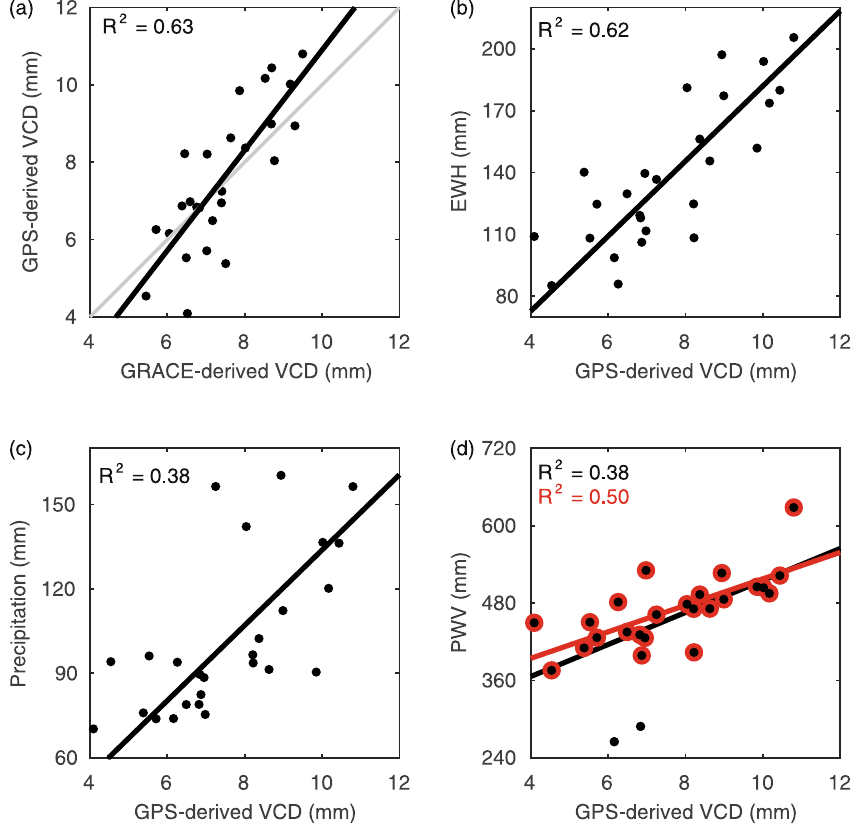
Figure 4. Empirical relations of the annual amplitude between GPS-derived VCD and other quantities. ( a ) for GRACE-derived VCD, ( b ) for EWH, ( c ) for precipitation, and ( d ) for PWV. The red line in ( d ) is the linear fitting line without two abnormal stations, Lijiang (YNLJ) and Shangri-La